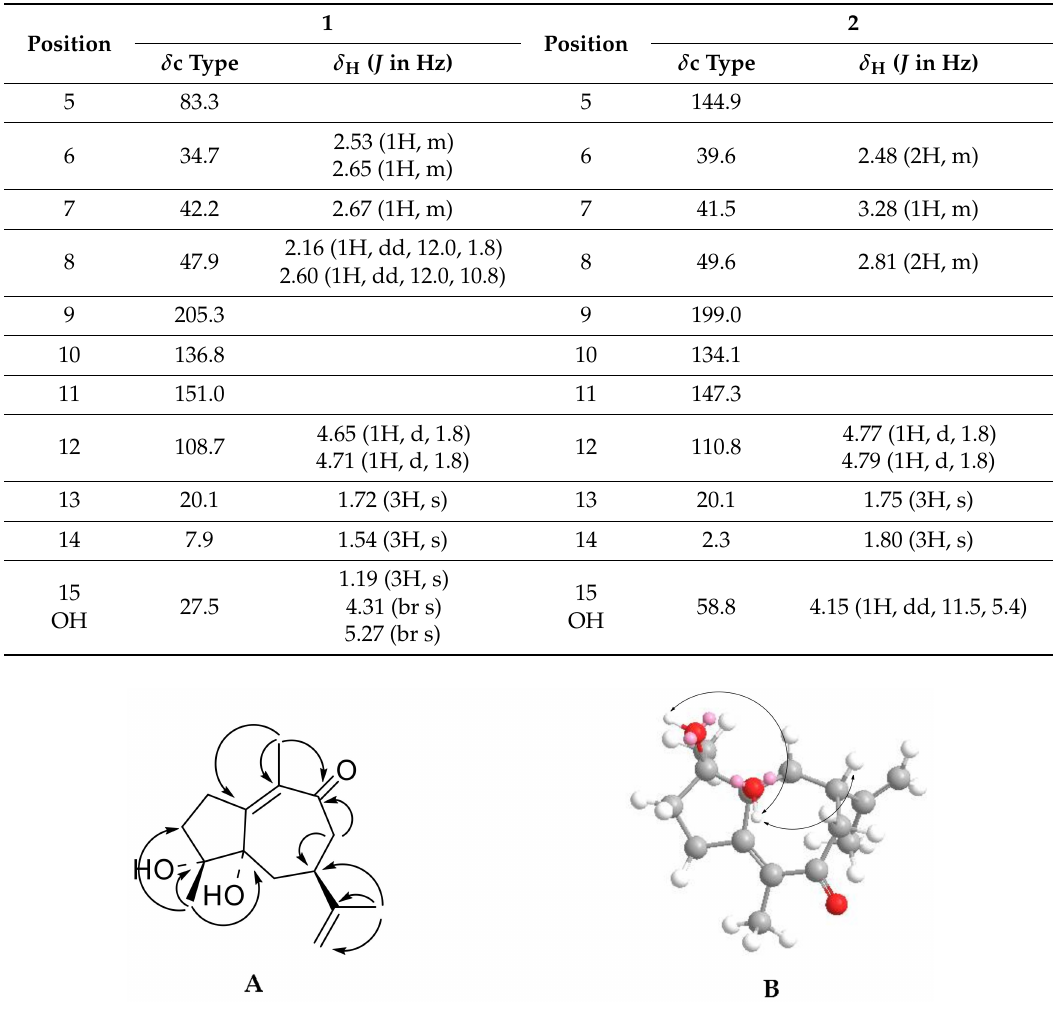
Figure 2. ( A ) Key HMBC (arrows) and ( B ) NOESY (arrows) correlations of compound 1